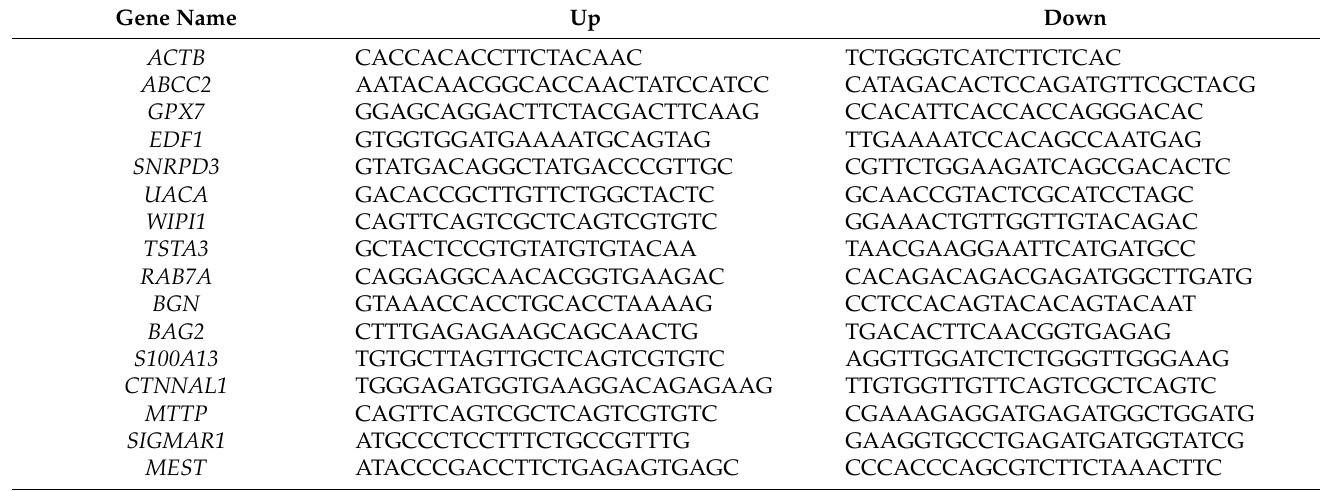
Table 1. Primer sequences for qRT-PCR testing of randomly selected